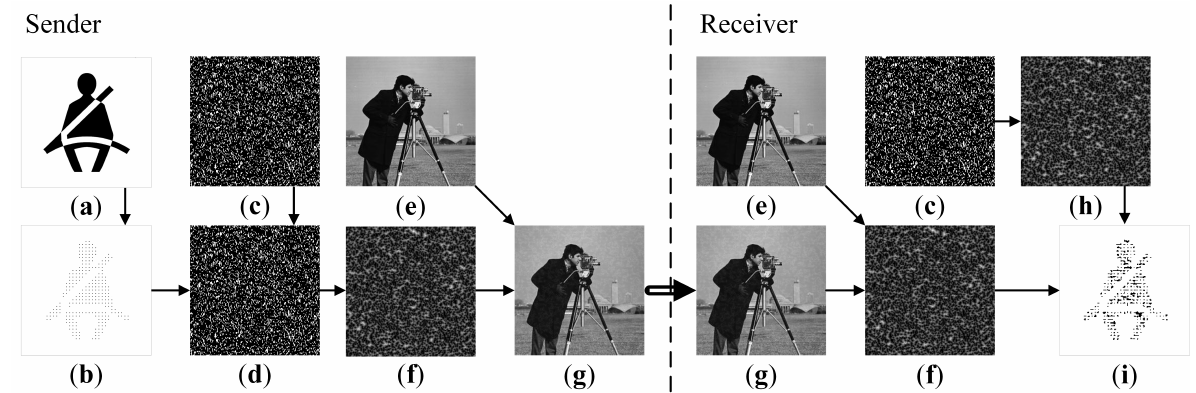
Figure 9. The flow chart diagram of the communication algorithm. Original image ( a ); dot-skeleton representation ( b ); initial conditions ( c ); perturbed initial conditions ( d ); cover image ( e ); perturbed self-organizing pattern ( f ); perturbed cover image ( g ); self-organizing pattern ( h ); difference image ( i